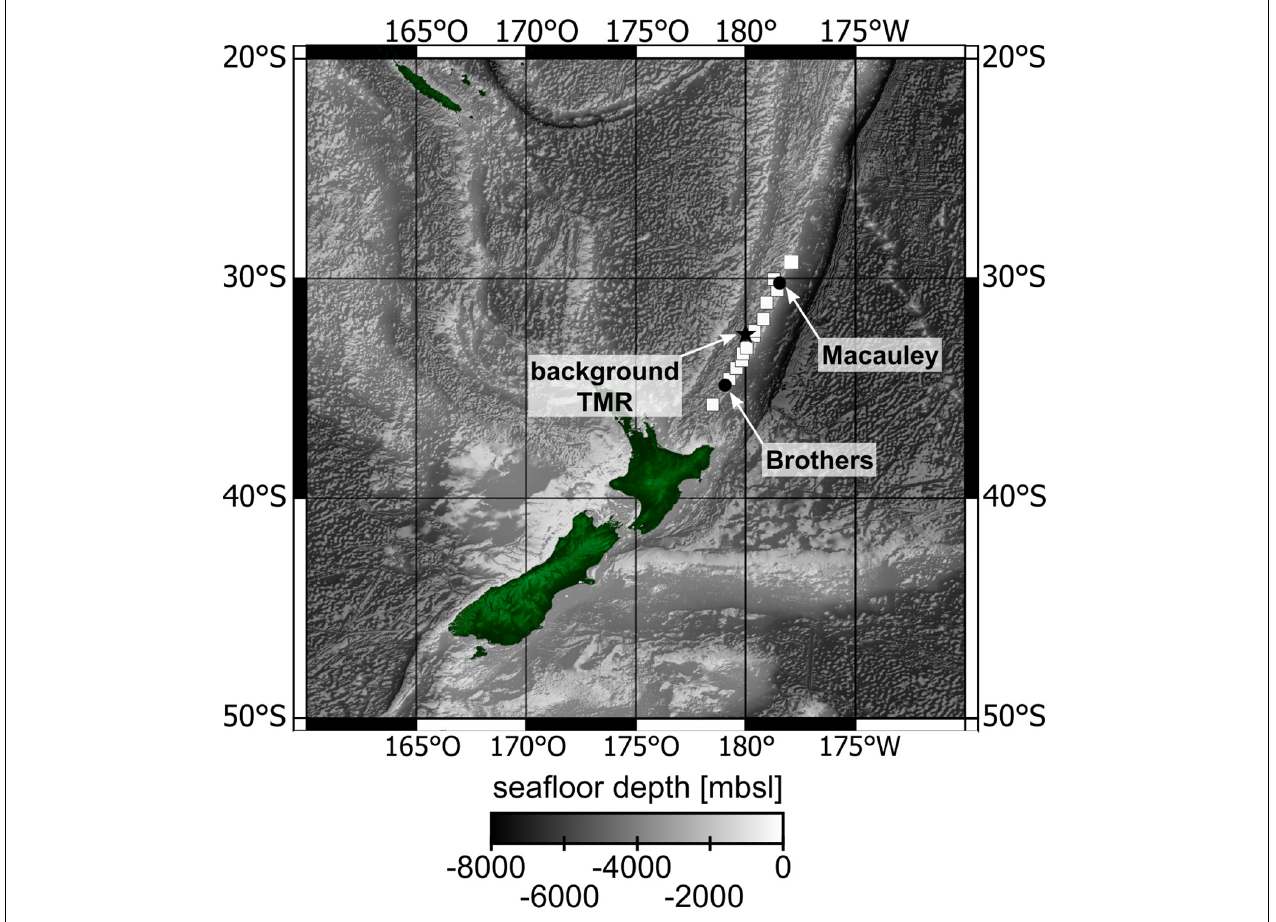
FIGURE 1 | Map of the southern Kermadec arc, showing the locations of the two sampled working areas, Macauley volcano (sampled between December 26th and 29th 2016) and Brothers volcano (sampled between January 7th and 17th 2017), as well as other active hydrothermal vent sites (white squares, de Ronde et al., 2007). The background station (station 28 from GP13) was sampled with a TMR (trace metal-clean rosette) (GEBCO Bathymetric Compilation Group,